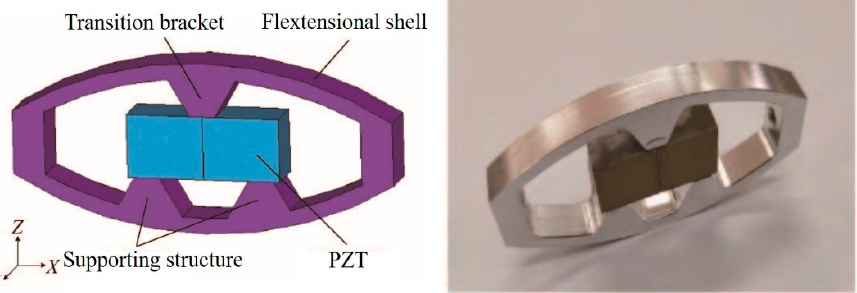
Figure 28. Piezoelectric transducer with transition bracket.